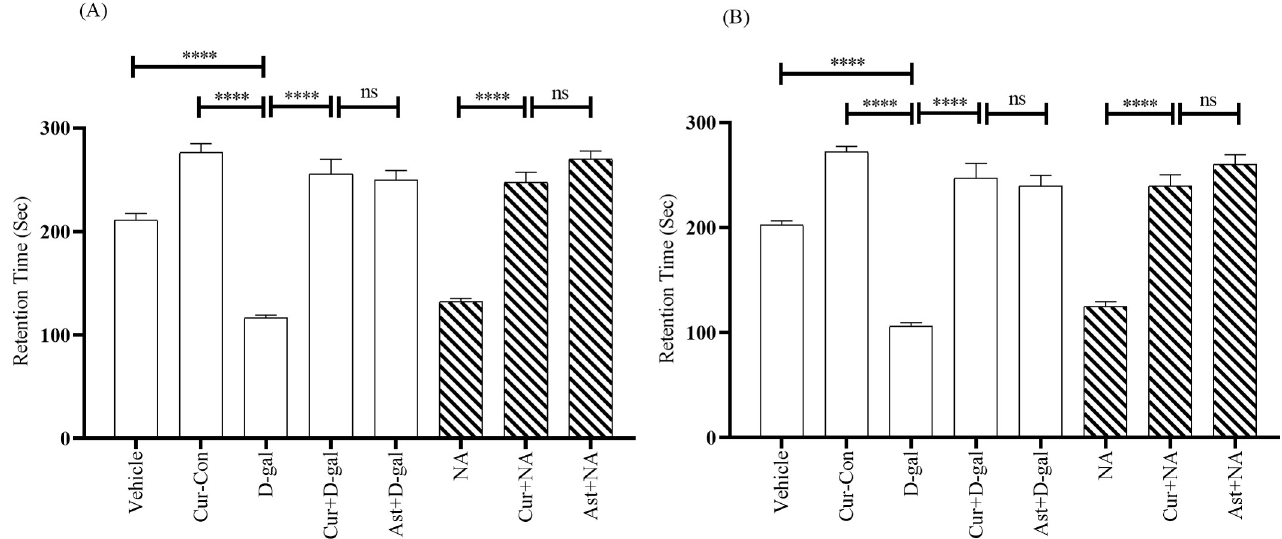
Fig 2. Effect of curcumin on RT in D-gal and NA mice group after 24 hours of training. The RT was calculated by performing PA tasks among Vehicle, Cur- Con, D-gal, Curcumin + D-gal, Ast + D-gal, NA, Curcumin + NA, Ast + NA groups. RT was expressed in second. Data was presented as mean ± SEM, n = 8 each group; ���� p < 0.0001, ns = not